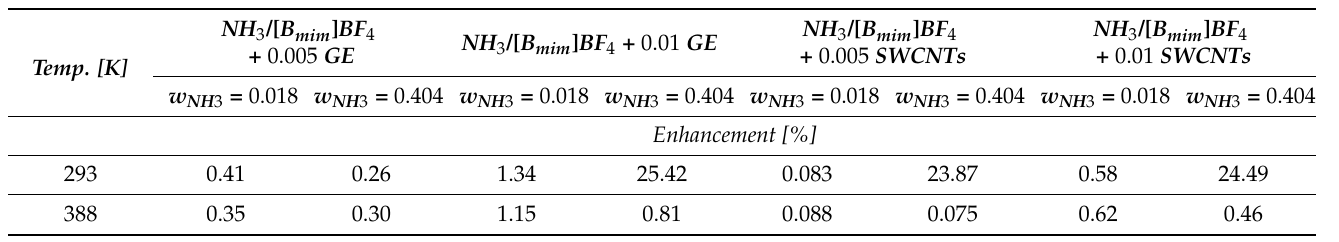
Table 8. Enhancement in